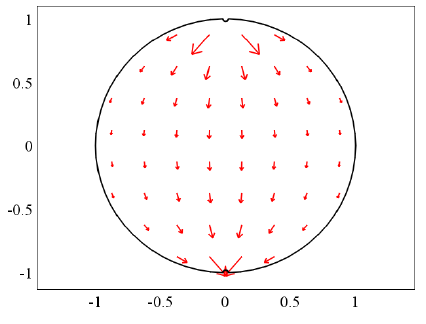
Figure 2. “Source” and “Field” diagrams.